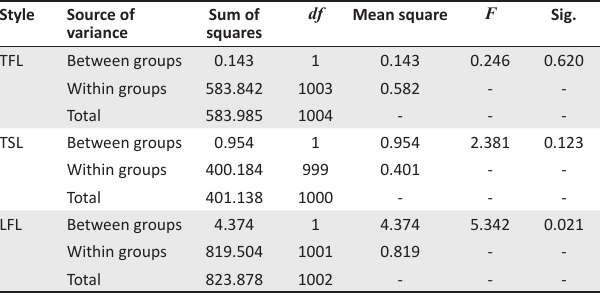
TABLE 1: ANOVA: differences between leadership style means across